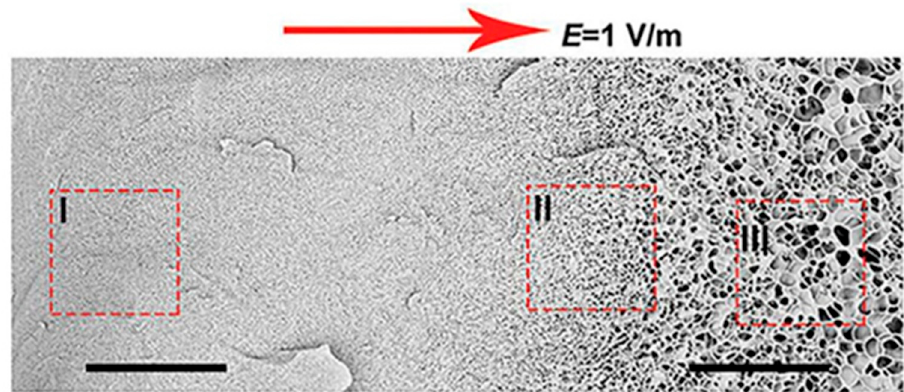
Figure 6. Scanning electron micrographs of freeze-dried sample with a large-ranged gradient structure along the direction of the electric field [22].